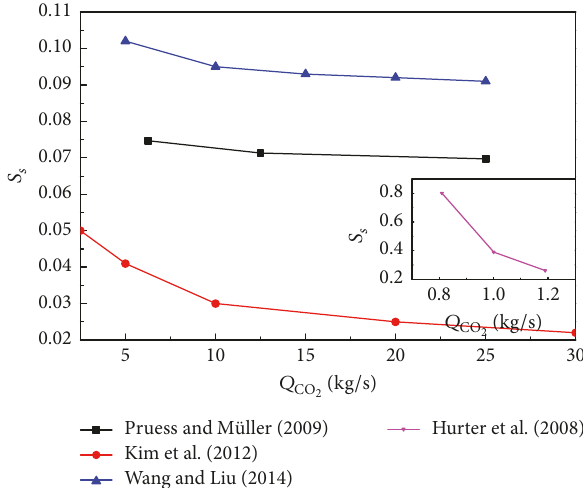
Figure 15: Relationship between 𝑆 𝑠 and 𝑄